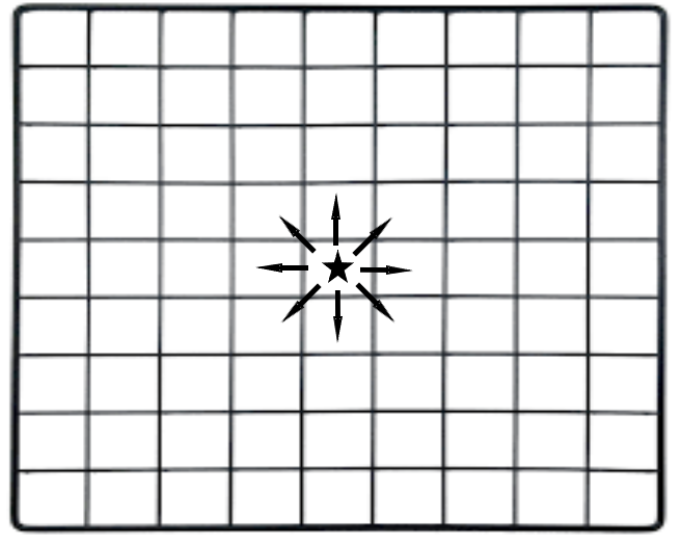
Figure 5. Search for surrounding cells in the initial tick of simulation.